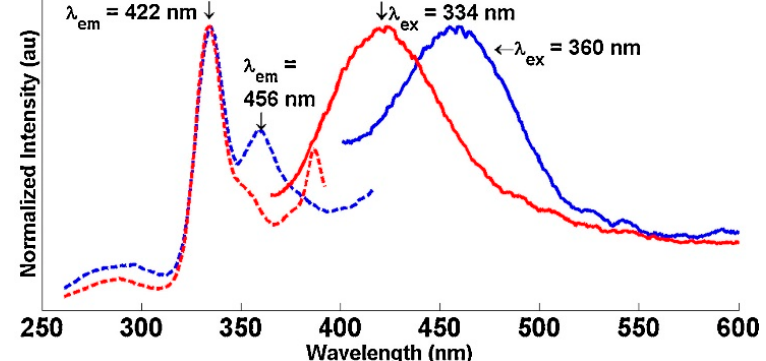
Figure 7. Solid-state luminescence spectra for BiOCl at 77 K. The excitation peaks are is matched with their corresponding emission peaks as indicated by the arrows. Reused with permission from